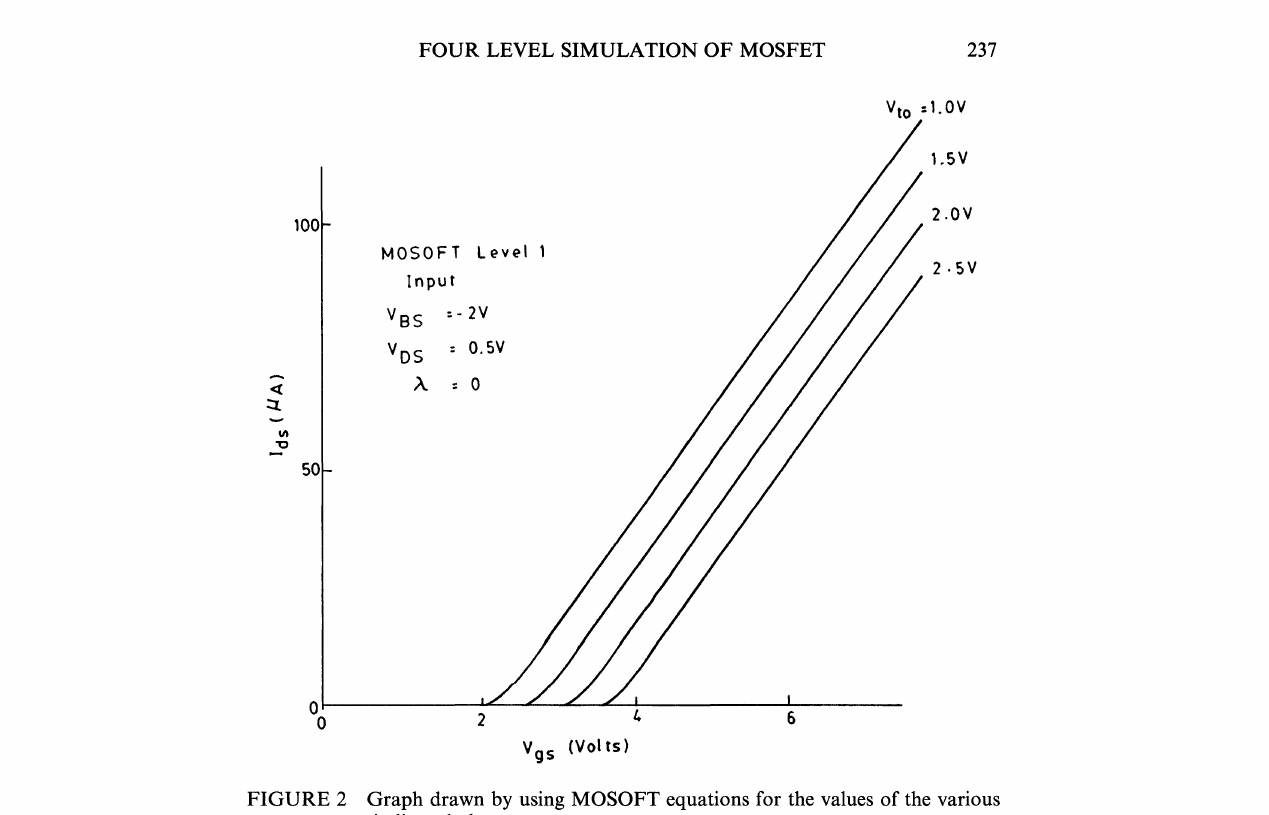
FIGURE 2 Graph drawn by using MOSOFT equations for the values of the various parameters as indicated